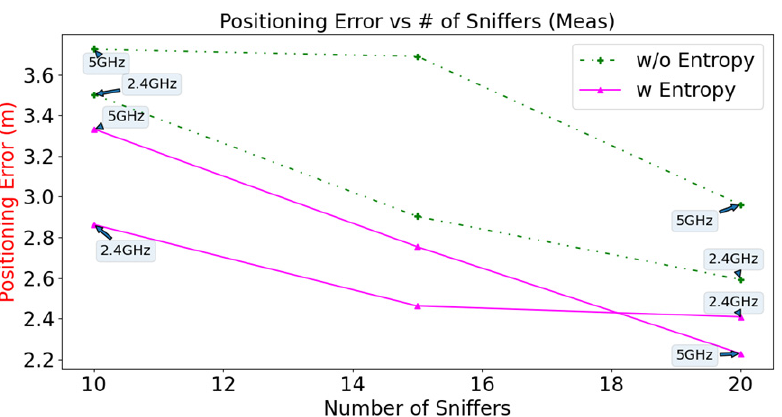
Figure 12. Positioning error versus number of Sniffers for different configurations of measurement data (10, 15, 20 Sniffers).